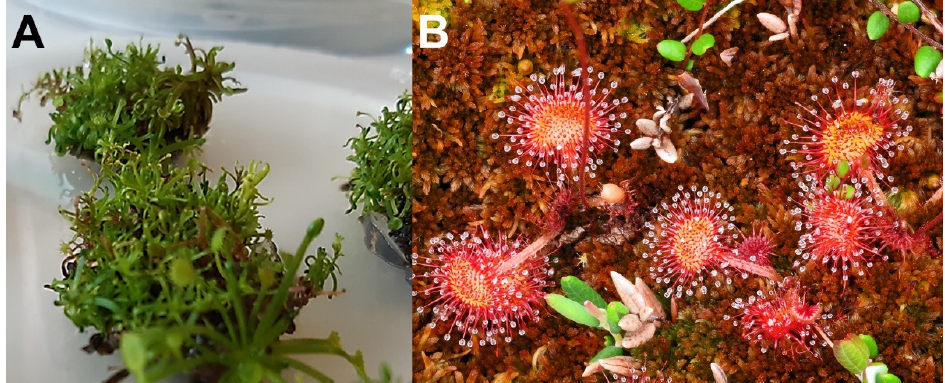
Figure 2. The sundew plants used in this study: ( A ) The in vitro propagation of D. rotundifolia on a Petri dish (photo: Tytti Sarjala) and ( B ) sundew growing wild on Sphagnum moss (photo: Hannu Nousiainen). The sundew cultivations in pots were morphologically alike to the tissue in figure ( A ).